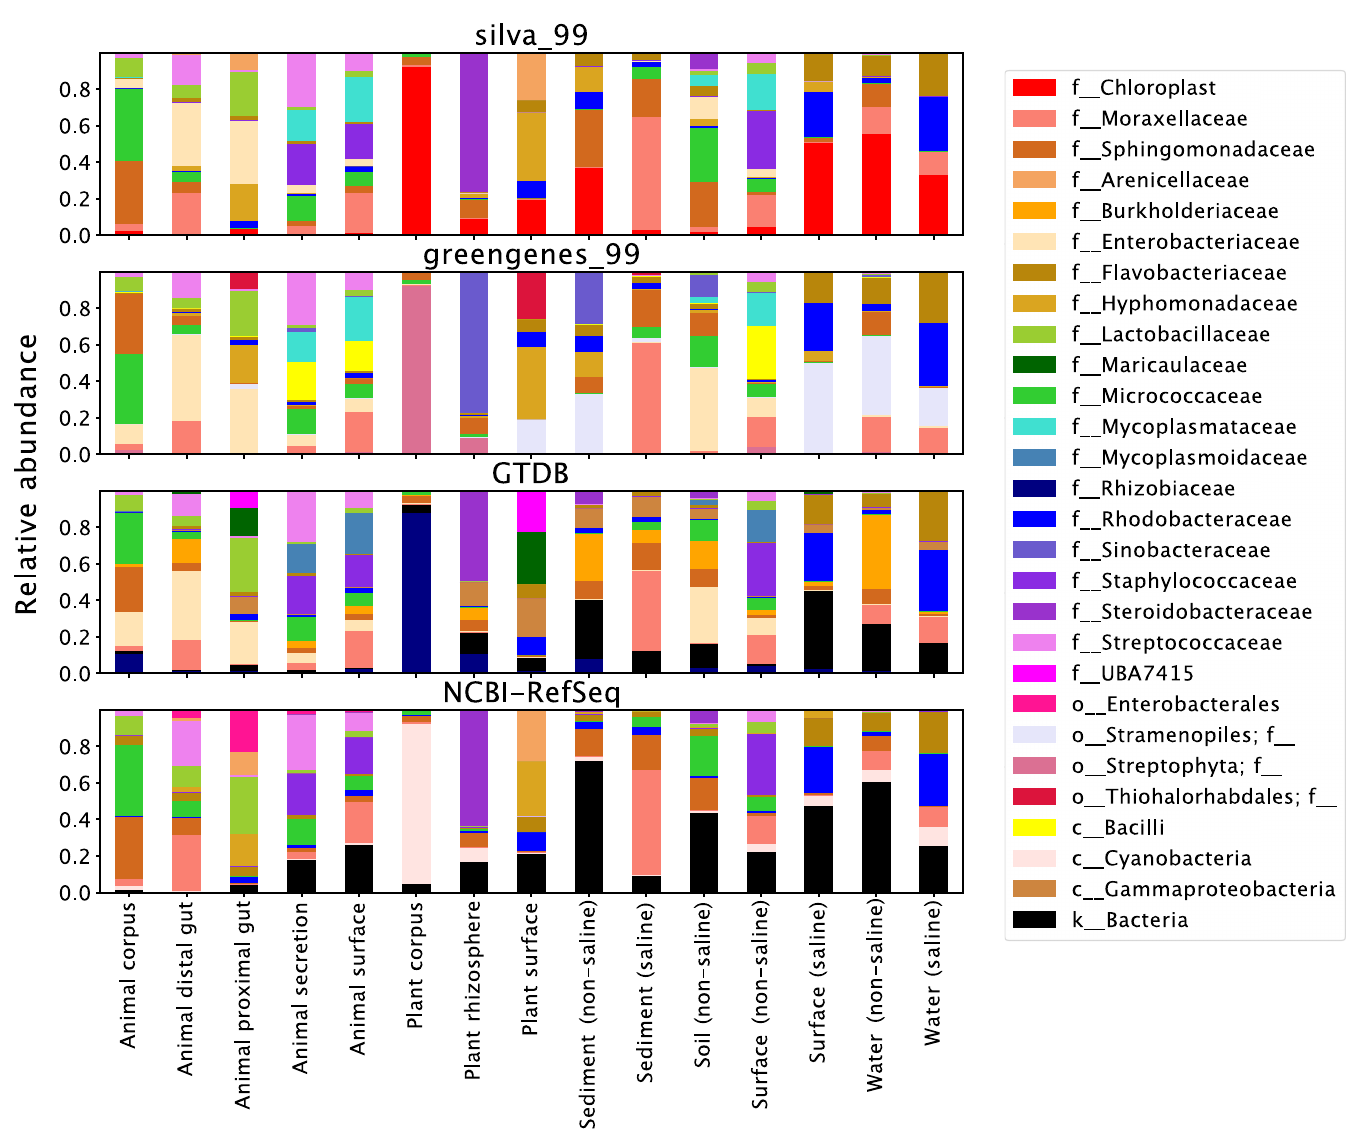
Fig 5. Average family-level taxonomic composition of EMP empo 3 types. Family-level classification as predicted by SILVA, Greengenes, GTDB, or NCBI-RefSeqs classifiers. Samples were grouped by EMPO 3 type to look at average family-level taxonomic composition of each sample type. Only taxa detected at a minimum of 10% relative frequency in at least one group are